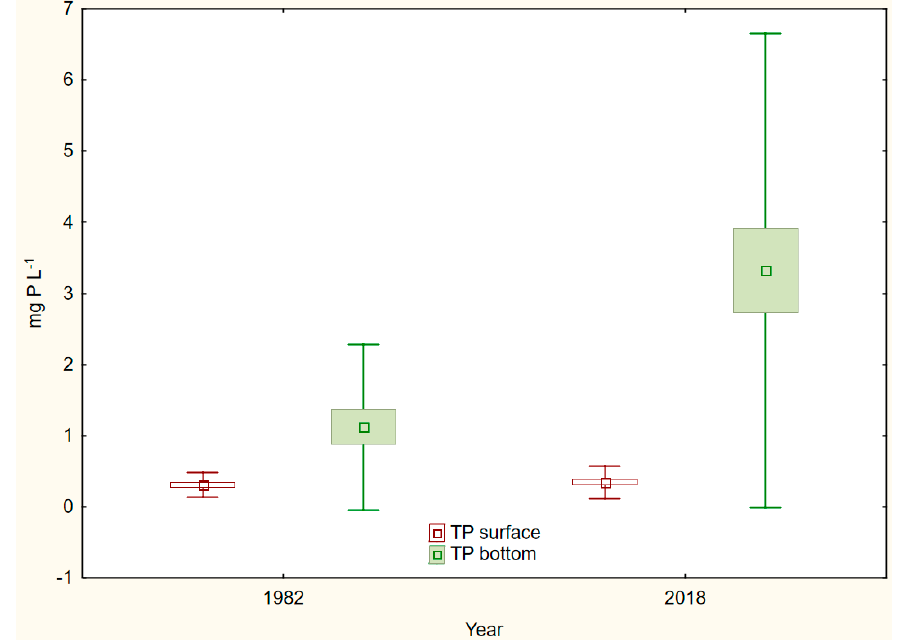
Figure 6. Mean annual (1982 and 2018) values of the total phosphorus content (±SD) in the water of Miłkowskie Lake.